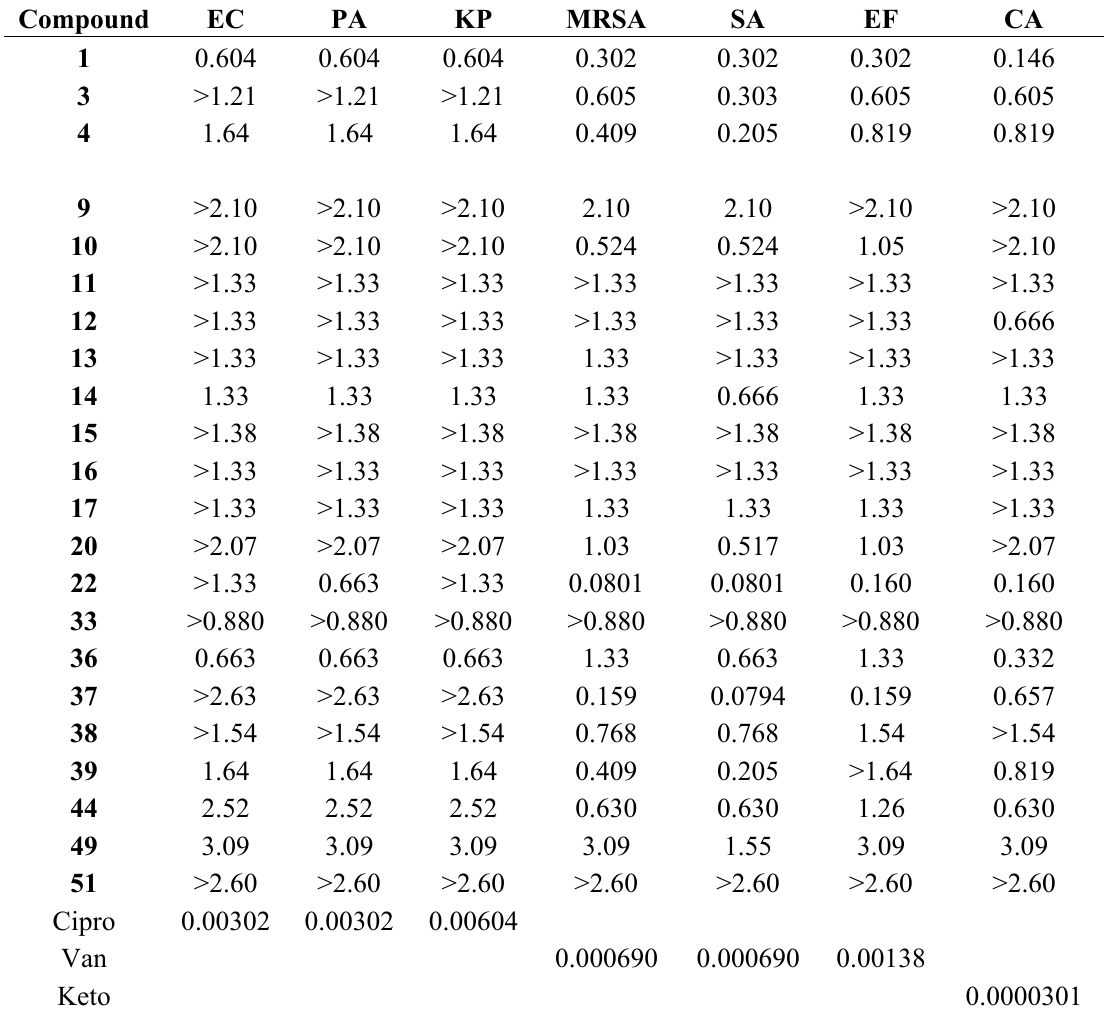
Table 6. Minimum inhibitory concentrations (MICs, mM) of the selected compounds obtained from the rhizomes of S.